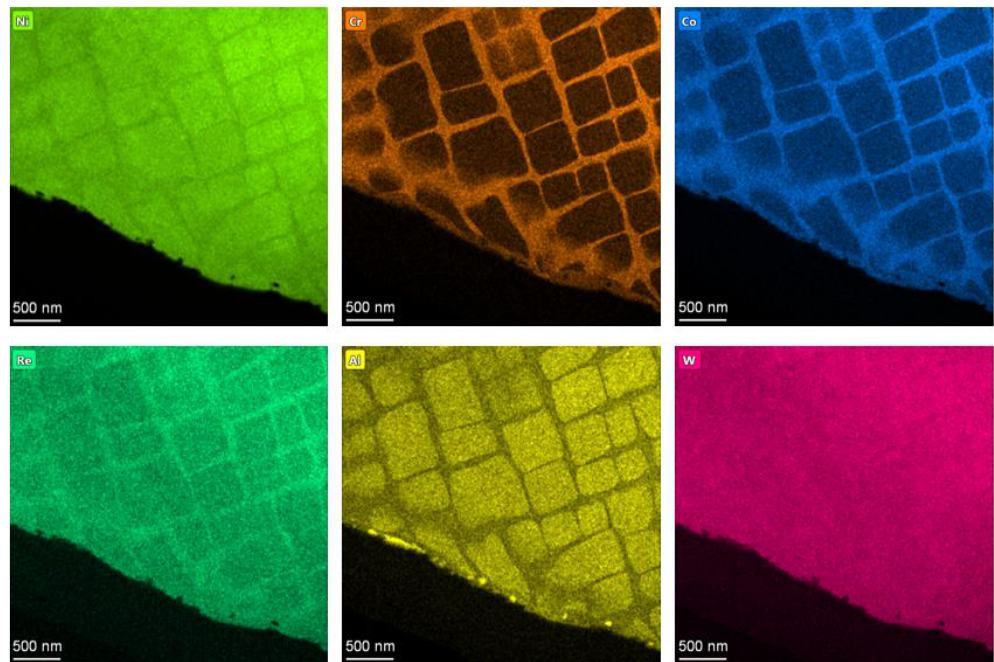
Figure 7. EDS maps of elemental distribution in the surface layer of SX alloy.